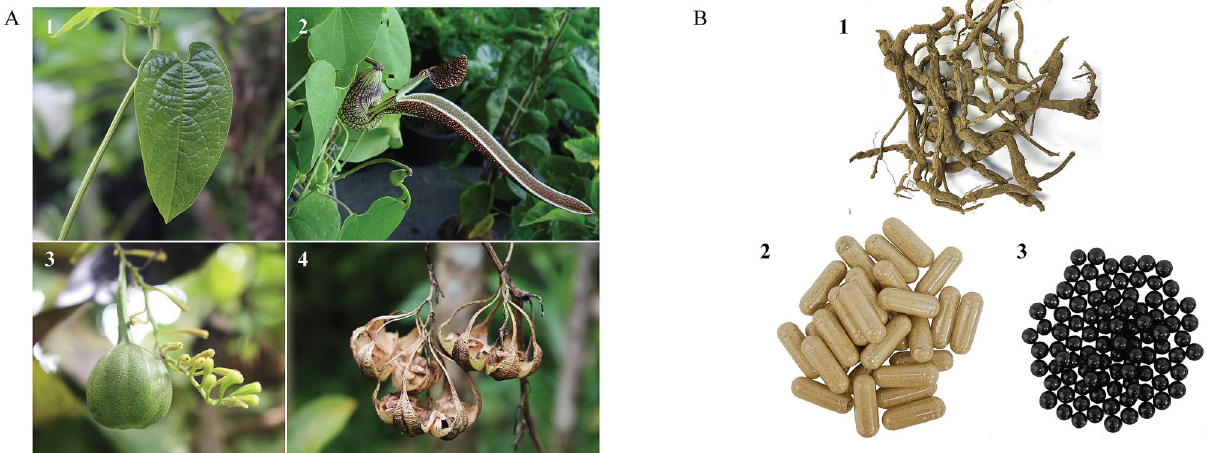
Figure 1. Aristolochia plant and herbal products. ( A ) Aristolochia plant; 1 : heart-shaped leaf, 2 : flower, 3 : infructescence, 4 : dry pods, ( B ) traditional herbal products; 1 : Krai-Krue crude drug, 2 : capsules of polyherbal formula, 3 : herbal pills. Figure 1A courtesy of Assist. Prof. Aekkhaluck